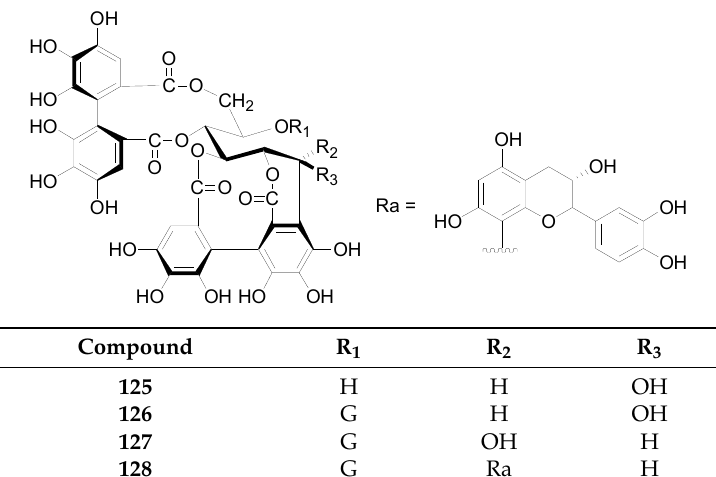
Table 8. Structures of compounds 129 – 132 .